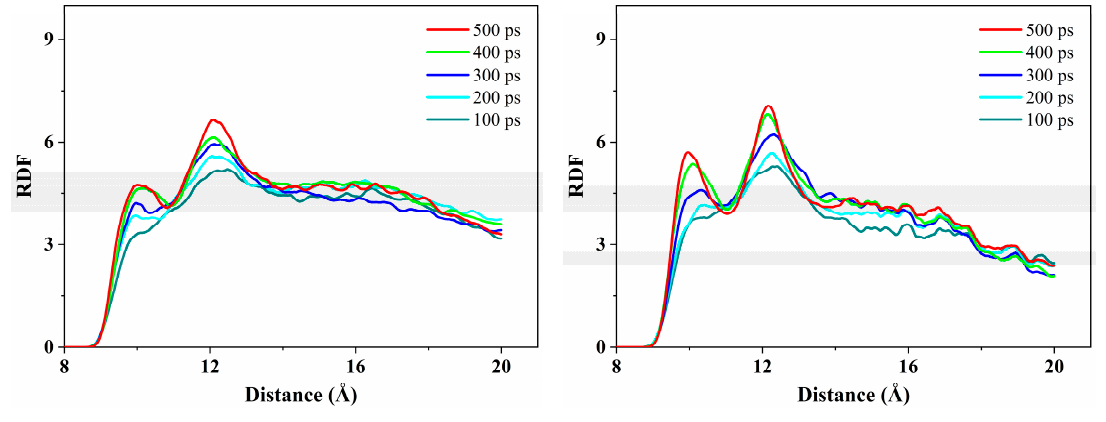
Figure 7. The radial distribution function (RDF) of hydrogen atoms in PE chains along the carbon nanotube (CNT) radial direction.